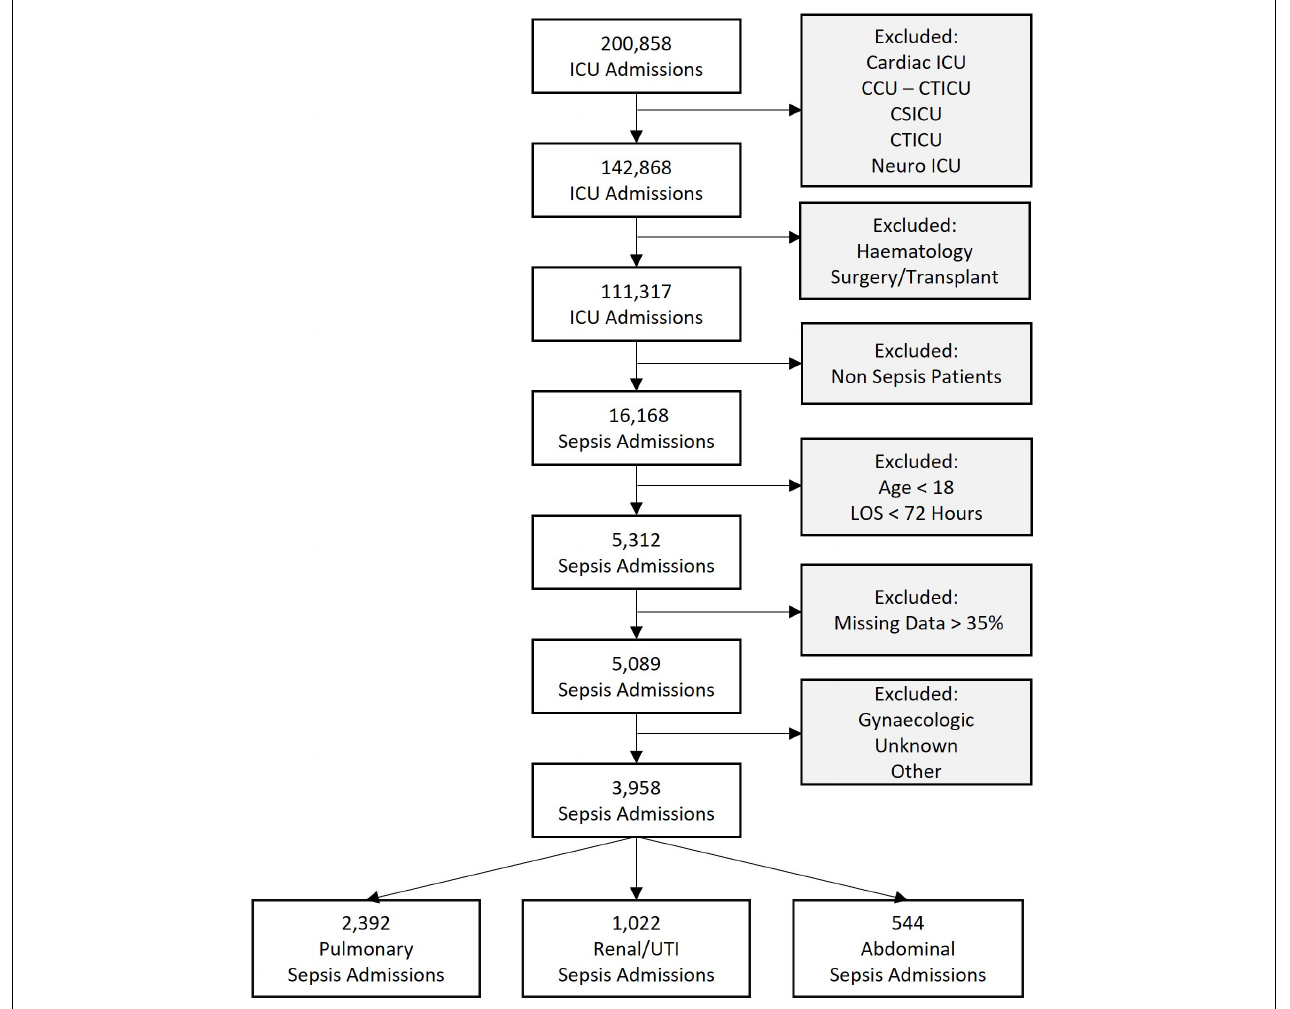
FIGURE 1 | Flowchart of sepsis cohorts analyzed showing the inclusion and exclusion criteria. ICU, intensive care unit; CCU-CTICU, critical care unit-cardiothoracic intensive care unit, CSICU, cardio-surgical intensive care unit; LOS, length of stay; UTI, urinary tract